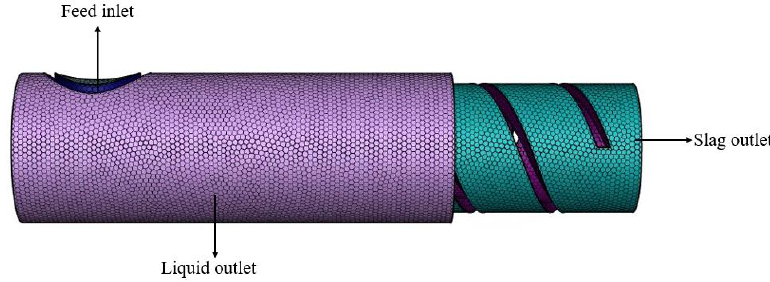
Figure 1. Dimensions of screw press.